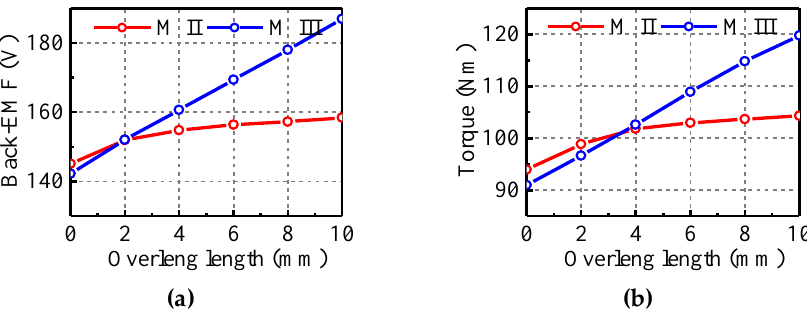
Figure 2. Back EMF ( a ) and torque ( b ) versus overhang length of M II and M III.